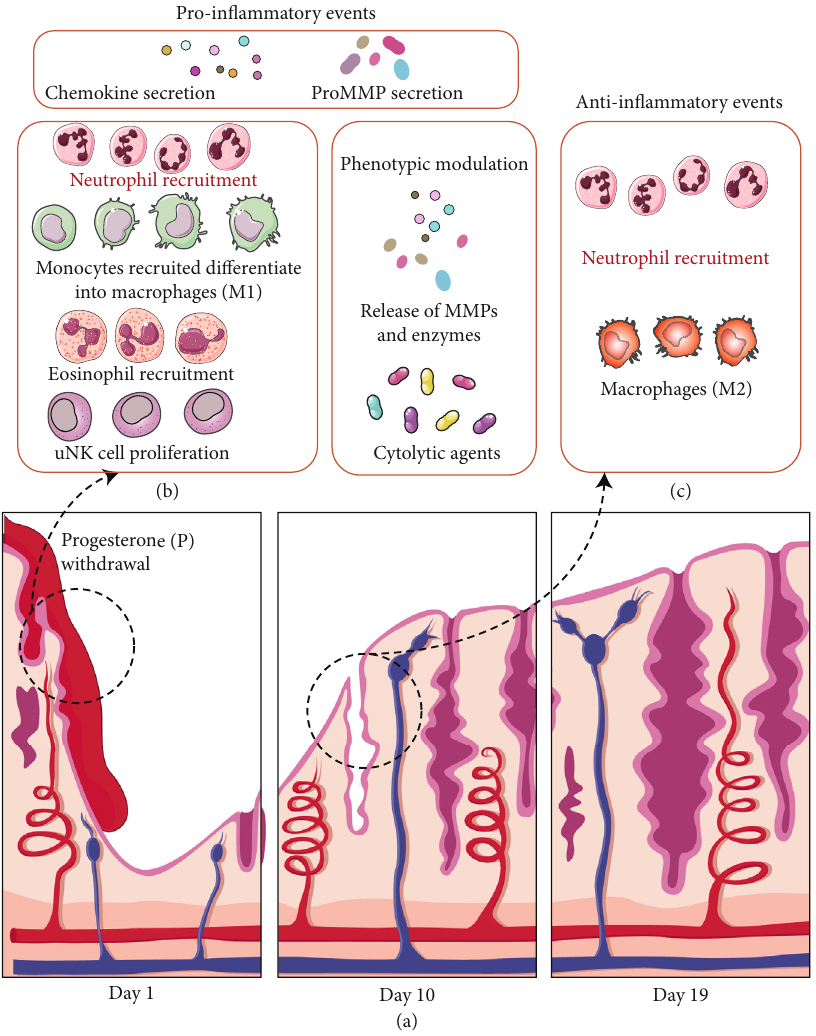
Figure 1: In fl ammatory events in menstruation. (a) Ovarian-derived estradiol and progesterone play a signi fi cant role in the structure and shape of the endometrium throughout the menstrual cycle. (b) Progesterone withdrawal leads to the release of chemokines into the surrounding tissues and the recruitment of neutrophils into the endometrium. Macrophages may have a proin fl ammatory (M1) phenotype in the early stages, and their phagocytic clearance of apoptotic cells is required to reduce local in fl ammation. Eosinophils are also recruited, while local mast cells become highly active and uterine natural killer (uNK) cells proliferate and release cytolytic chemicals. As these cells undergo a phenotypic shift, MMPs and degradative enzymes are released, stimulating the MMP activation cascade and driving ECM breakdown and endometrial rupture. (c) After menstruation, macrophages remove cellular debris while neutrophils of di ff erent phenotypes assist in the remodeling and repair of the functional endometrial